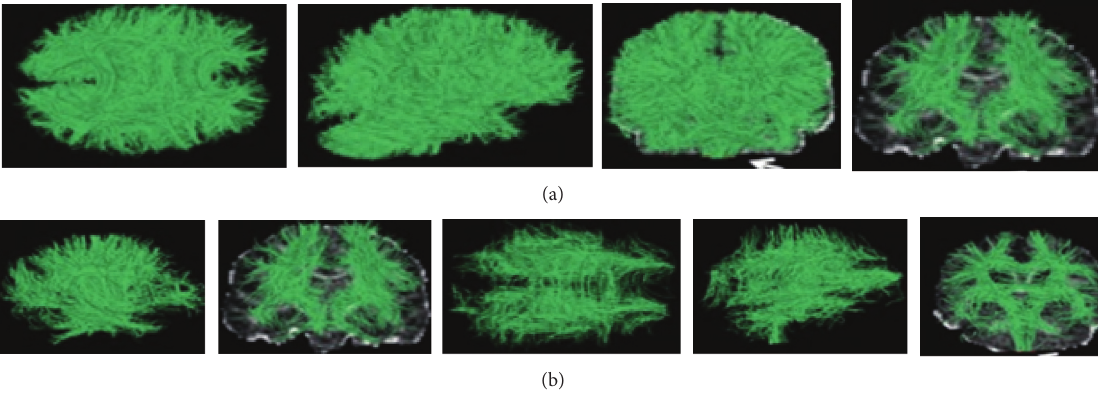
Figure 6: Time-scale transformation detection: (a) duration of 65 seconds; (b) duration of 155 seconds.